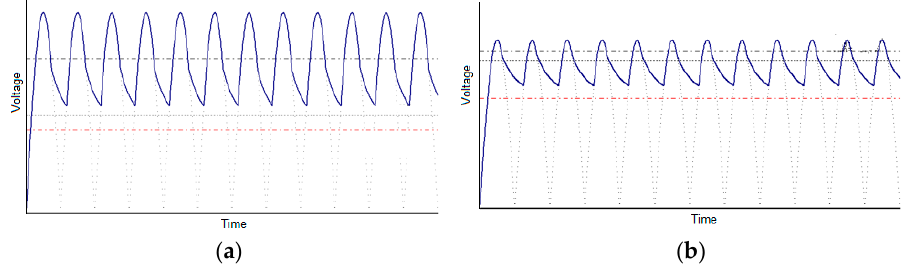
Figure 5. The waveforms of the section voltage when supplied with full-wave rectified voltage (clas- sical supply) and a 2 mm dust layer on the collector surfaces with dust resistivity: ( a ) 10 11 Ω × cm; ( b ) 10 13 Ω × cm.